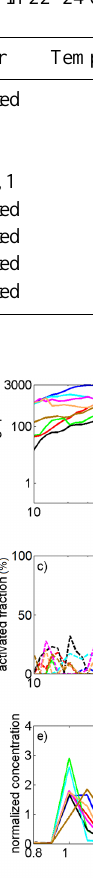
Figure 6. (a) Total particle size distributions, (b) size distributions of activated particles, (c) activated fraction of particles as a function of particle diameter, (d) cloud droplet size distributions and growth factor distributions for (e) 80nm and (f) 150nm particles for the dif- ferent periods of the cloud event observed on 22–24 October 2011. In (b) and (c) data for particles smaller than 80nm in diameter are illustrated with dashed lines due to the inaccuracies discussed in the text. In (e) and (f) normalized concentration means that the integral of the particle concentrations over GF =